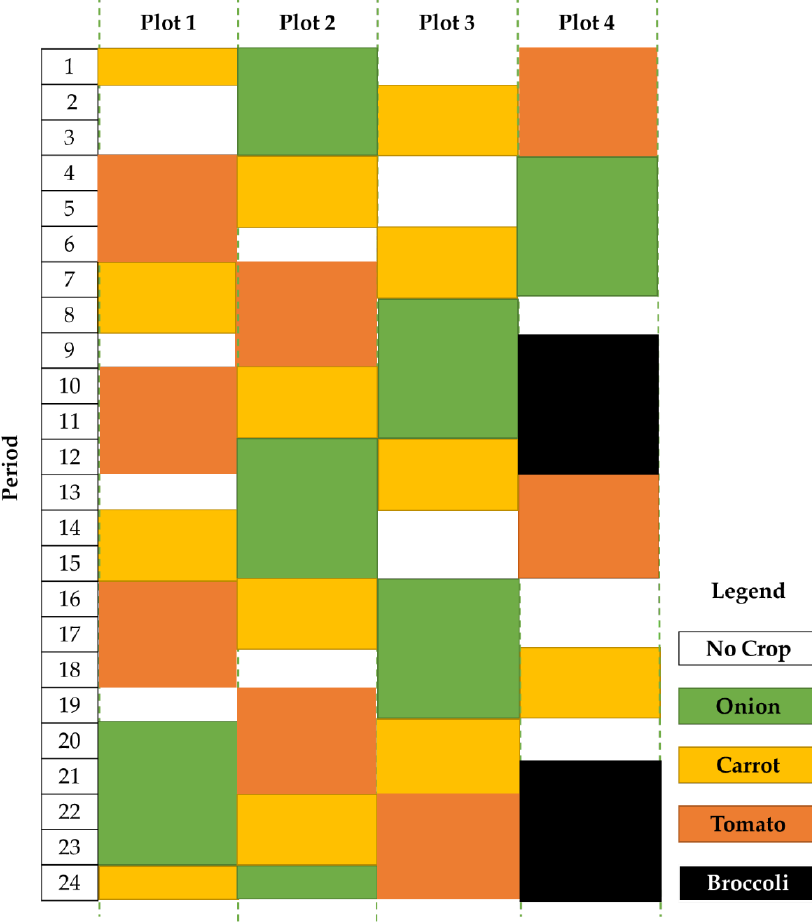
Figure 6. Representation of the solution obtained by Cbc in scenario 3. Onion is cultivated once on plots 1 and 4, and twice on plots 2 and 3. Carrot is cultivated once on plot 4, thrice on plot 1 and four times on plots 2 and 3. Tomato is cultivated once on plot 3, twice on plots 2 and 4, and thrice on plot 1. Finally, broccoli is cultivated twice only on plot 4.